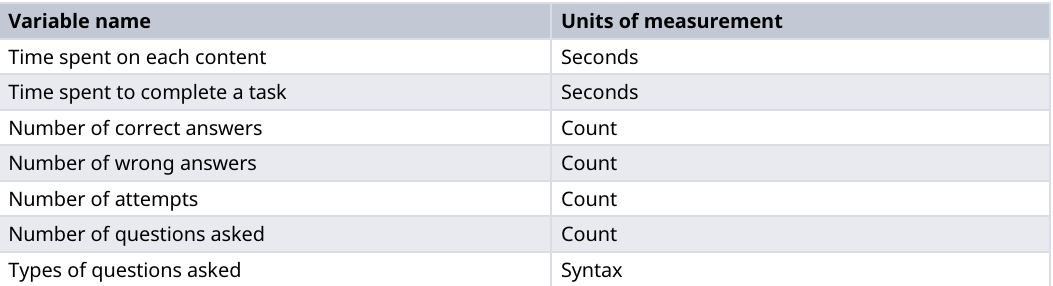
Table 1. Variables to be tracked from activity